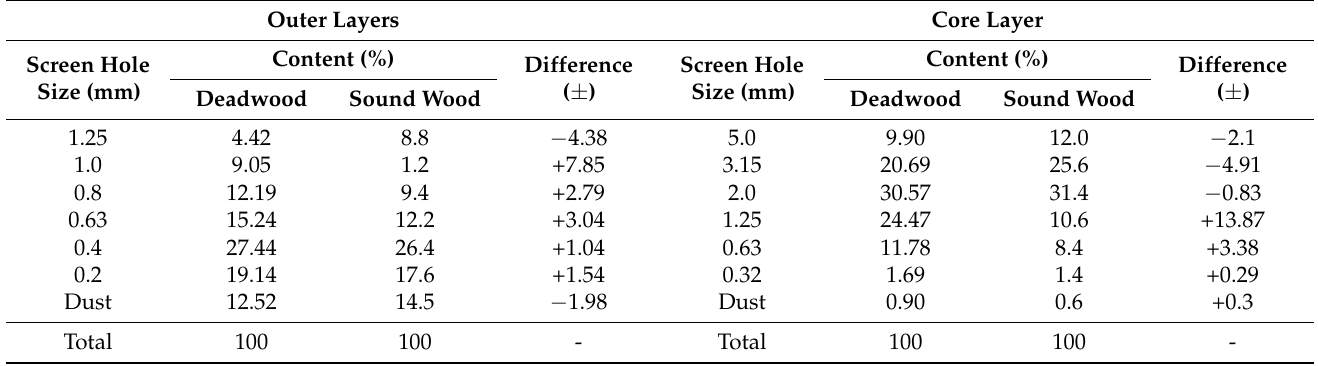
Table 1. Fraction analysis (by % weight) of wood particles from deadwood and sound